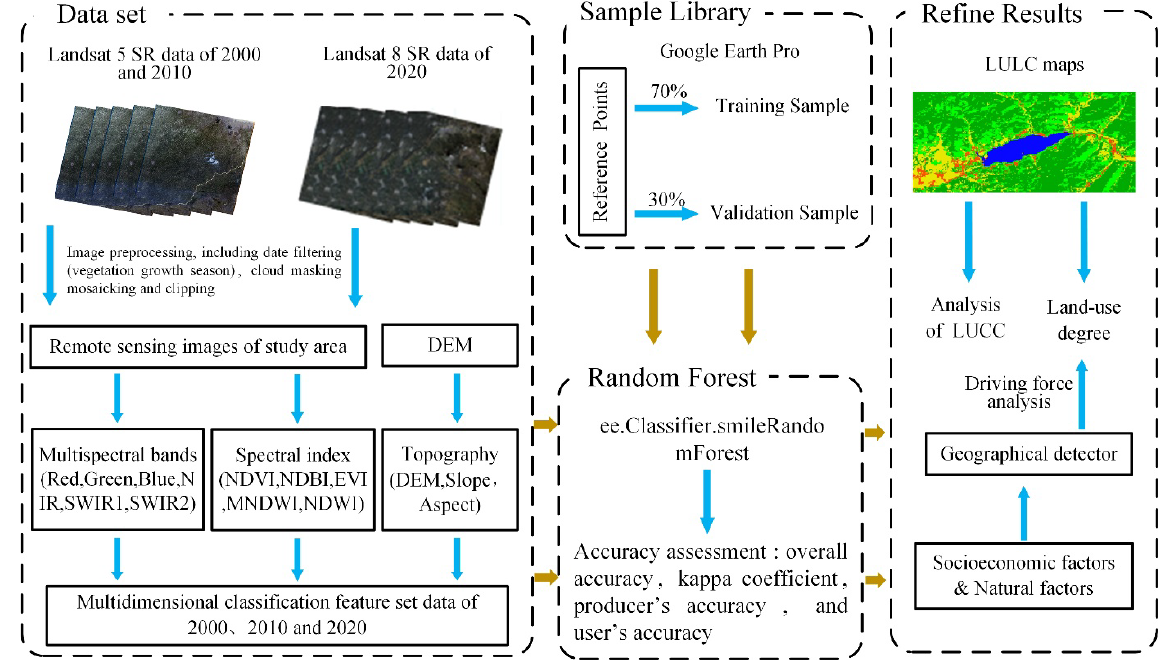
Figure 3. The flowchart of this research.